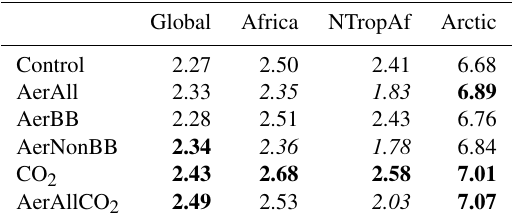
Table 2. Changes in surface temperature from pre-industrial times (calculated using a pre-existing PiControl simulation) to the period 2070–2100 in the control scenario and each experiment, globally and in several regions. Africa is defined as per the emissions region, visible in the difference panels in Fig. 1; NTropAf (northern tropical Africa) is the high-emissions region from 0–30 ◦ E and 0–10 ◦ N; the Arctic is 60–90 ◦ N. The values are bolded (italicised) to indicate statistically significant higher (lower) temperatures than the control